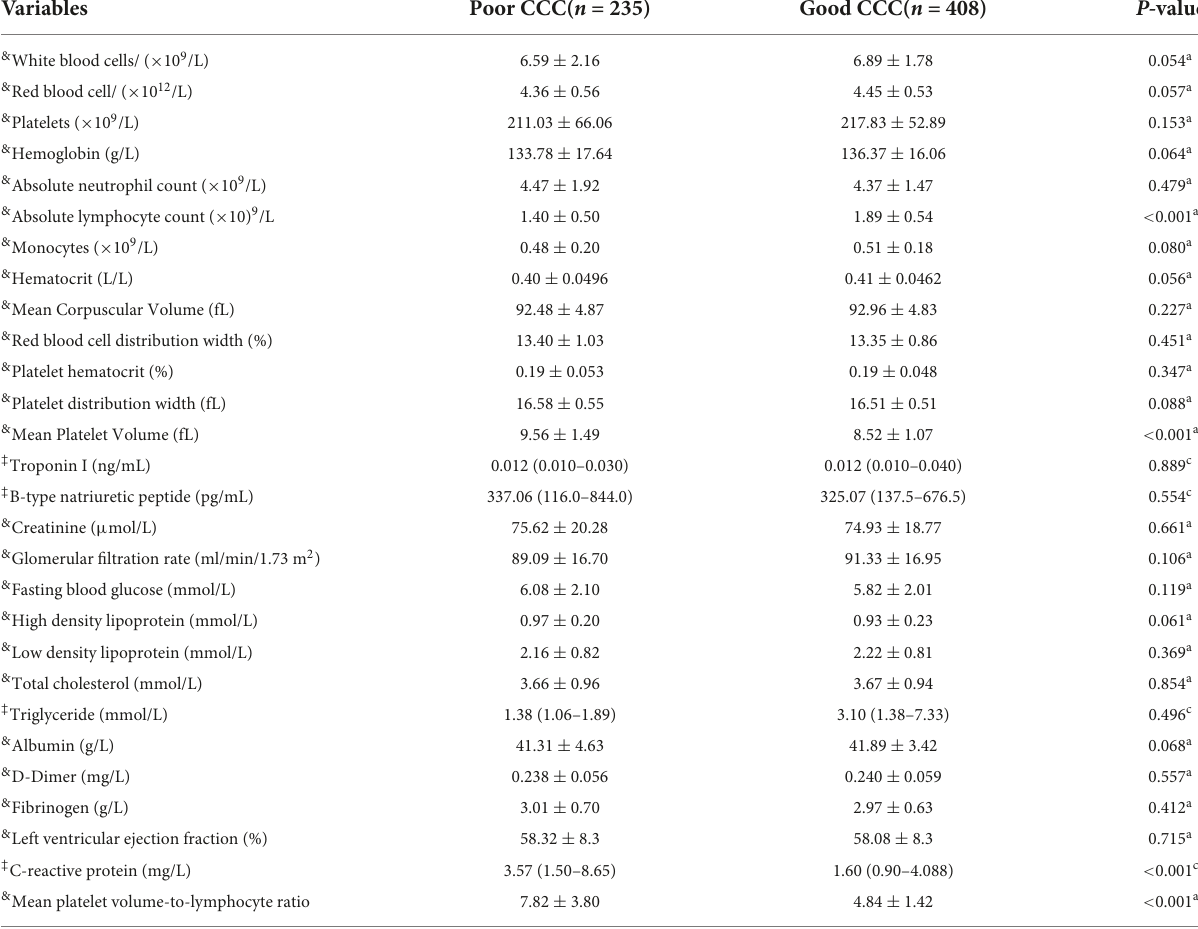
TABLE 2 Comparison of biochemical parameters between the two